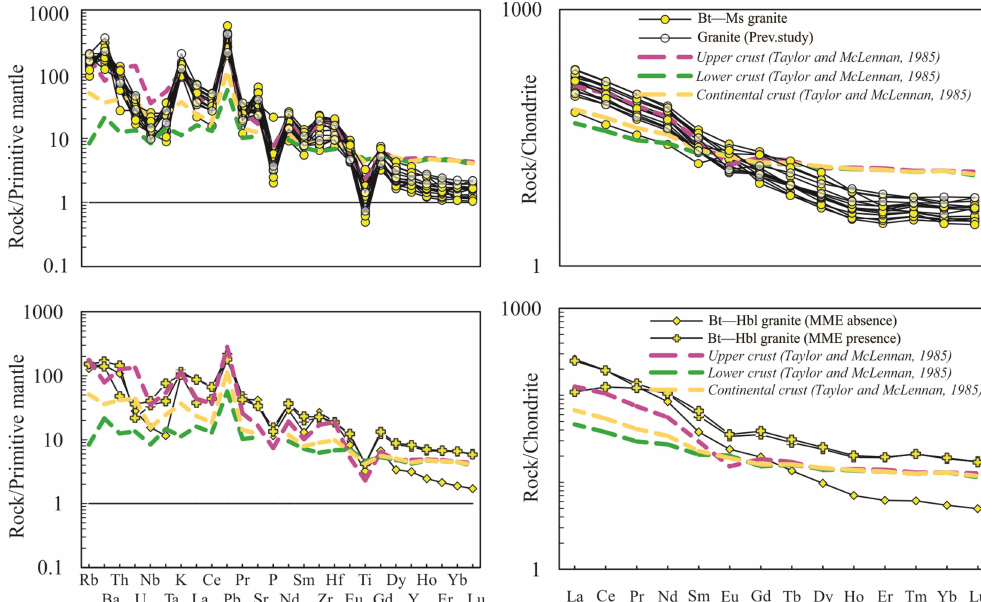
Fig. 5. Primitive-mantle-normalized multi-element and chondrite-normalized REE patterns for granitoids samples from the Baidrag area. These diagrams are normalized to the primitive mantle and chondrite compositions of Sun and McDonough (1989), and include data from Buchan et al. (2002), Jahn et al. (2004), and Zhang et al. (2015).